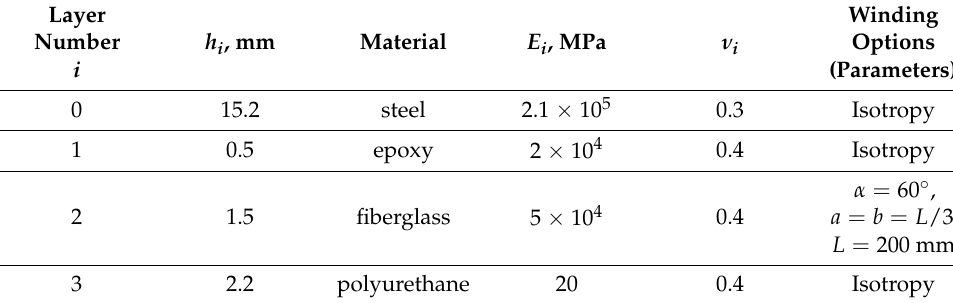
Table 1. Geometric and physical parameters of layers